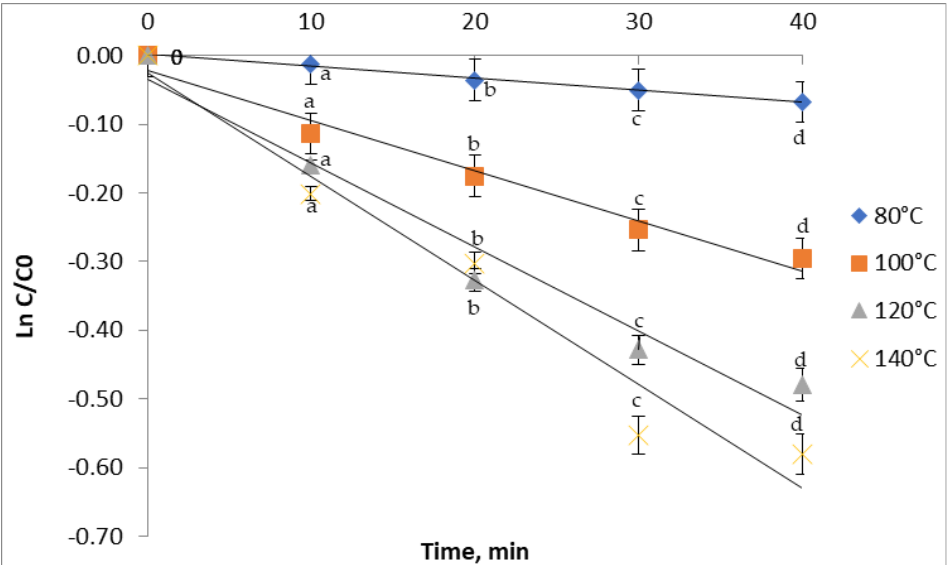
Figure 5. Isothermal degradation of the antioxidant activity in red grape skin extract treated at different temperatures.